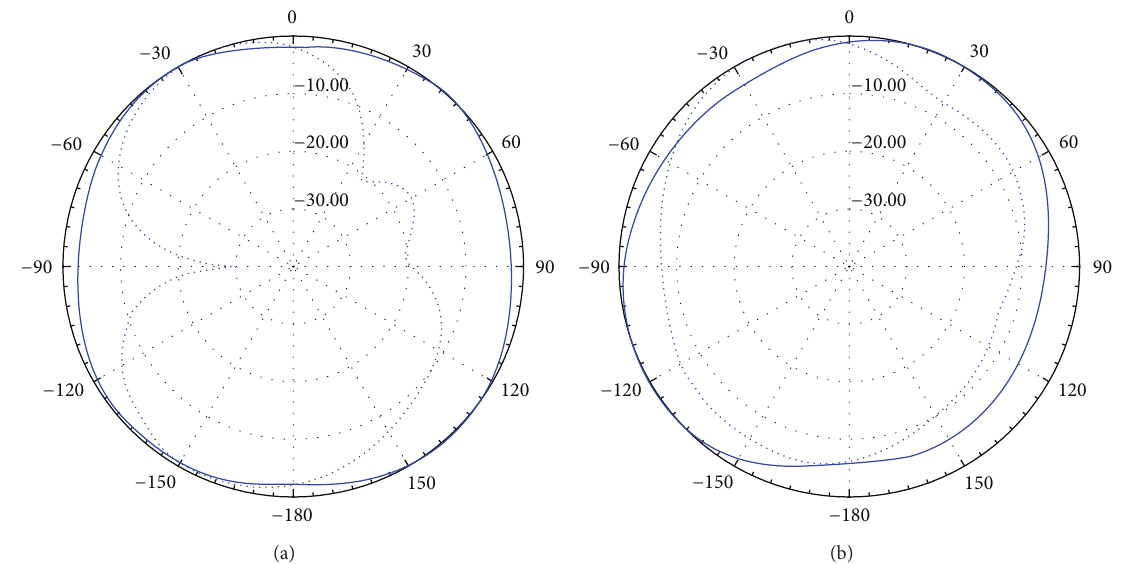
Figure 12: Normalized radiation pattern of (a) the wideband antenna and (b) the proposed tunable filter-antenna at 4.18 GHz (X-Z/Y-Z plane: solid/dotted line).